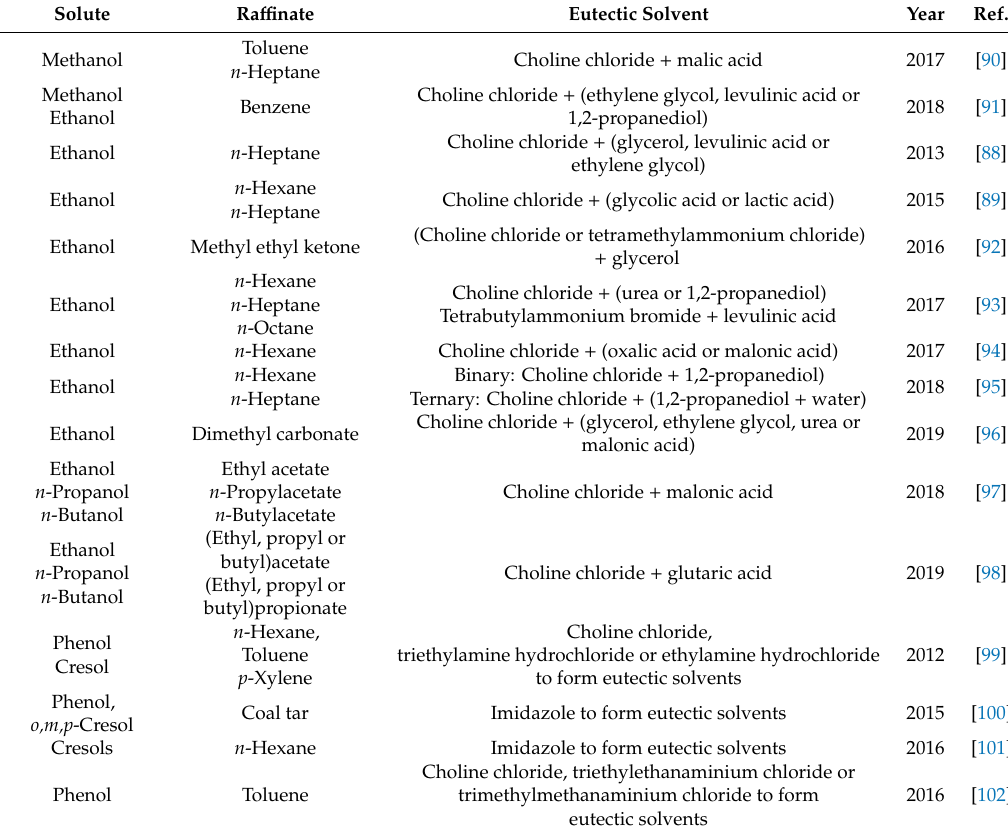
Table 5. Eutectic Solvents in the Liquid–liquid Extraction of Alcohols from Hydrocarbons.